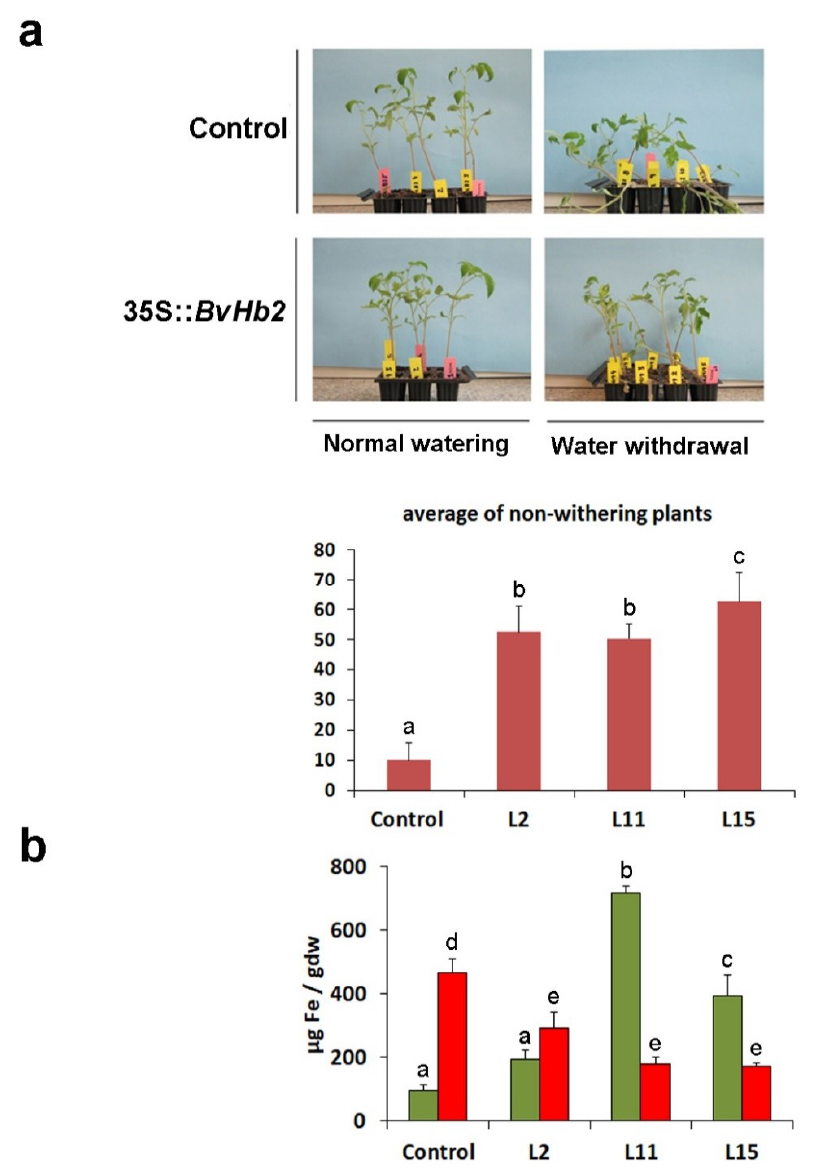
Figure 4. Transgenic tomato lines overexpressing BvHb2 present higher drought-induced withering resistance and altered iron distribution. ( a ) Overexpression of BvHb2 conferred resistance to water deprivation. Upper panel: irrigation was stopped for 3-week-old plants, and pictures were taken after 5 days. Lower panel: Quantification of withering plants. Bars represent means ± standard error. X axis represents the control line (transformed with the empty vector) and the di ff erent transgenic lines (transformed with 35S:: BvHb2 ). Data with di ff erent letters di ff er significantly ( p < 0.05), as determined by Tukey’s HSD test ( n = 20). ( b ) Overexpression of BvHb2 increases iron content in leaves and decreases iron content in fruit. Plants were grown until mature fruits were developed (approximately 4 months). Leaves (green bars) and fruits (red bars) were obtained. Dry weight was determined, and ions were extracted with HNO 3 . Iron content was determined by atomic absorption spectroscopy. X axis represents the control line (transformed with the empty vector) and the di ff erent transgenic lines (transformed with 35S:: BvHb2 ). Bars represent means ± standard error. Data with di ff erent letters di ff er significantly ( p < 0.05), as determined by the Tukey HSD test using biological replicates ( n =